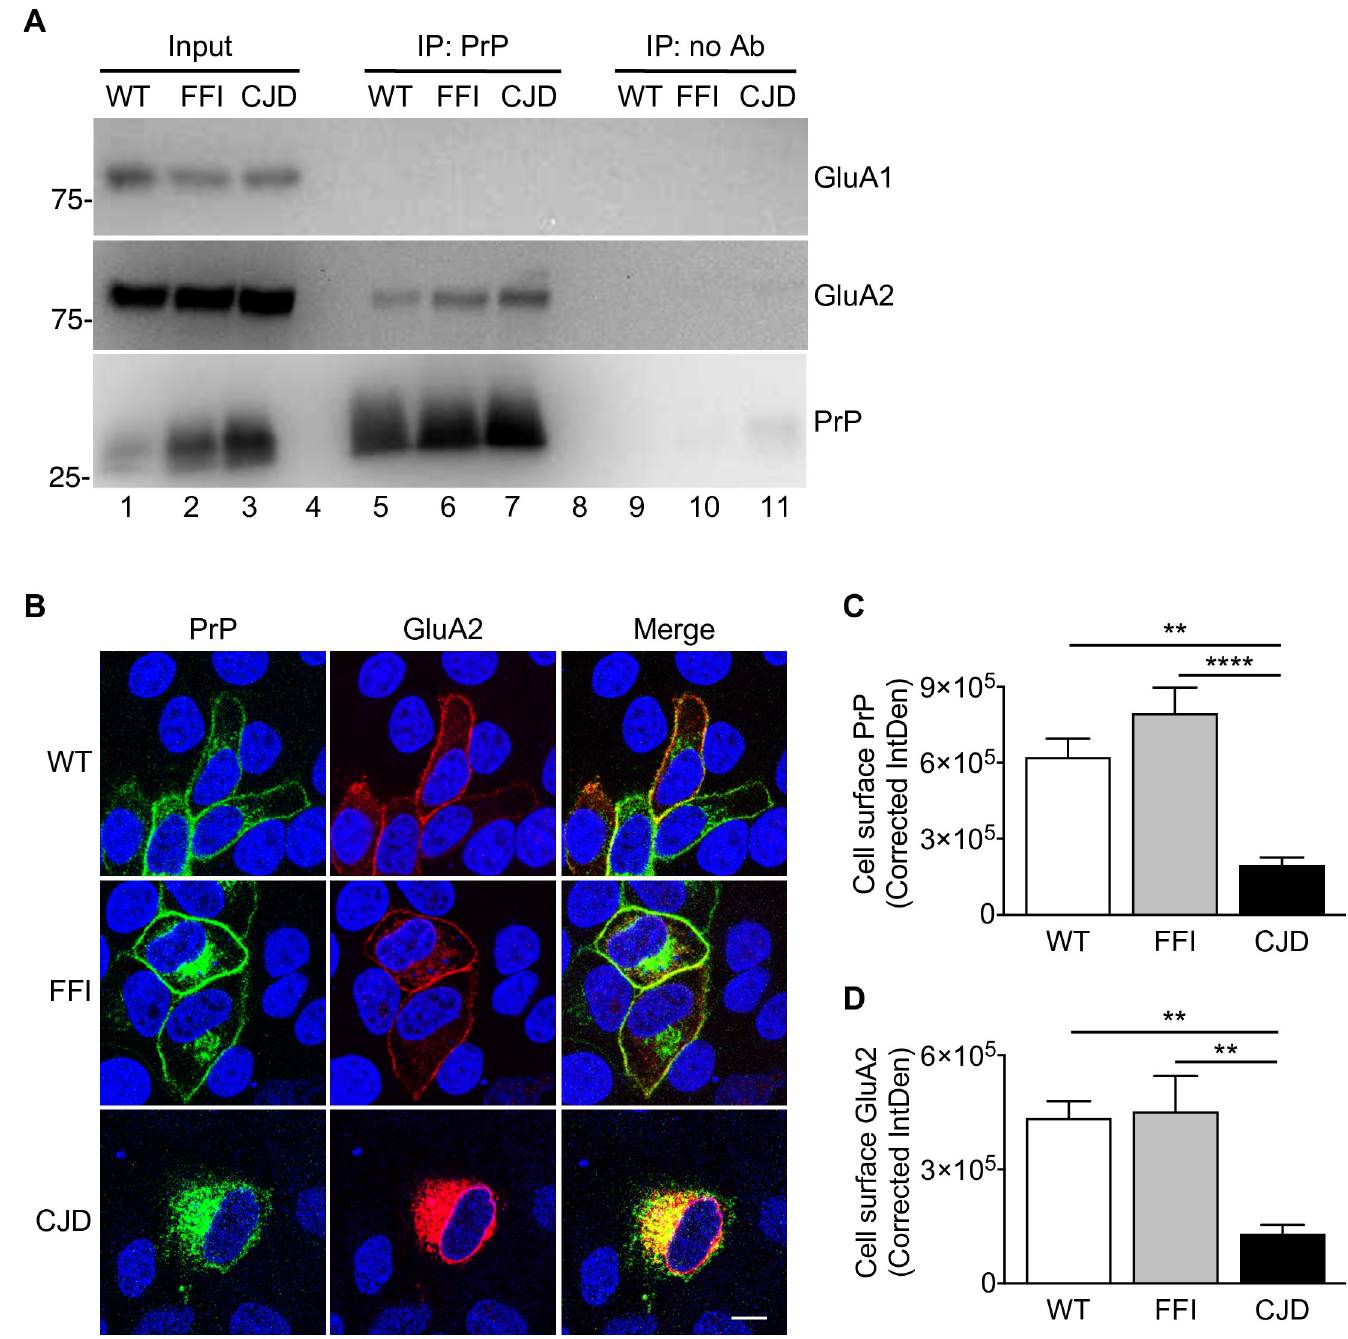
Fig 2. Mutant PrP interacts with the GluA2 AMPAR subunit impairing its membrane delivery. (A) Hippocampal protein extracts (500 μ g) from WT, FFI and CJD mice were incubated with uncoated magnetic beads (IP: no Ab) or magnetic beads coated with anti-PrP monoclonal antibody 94B4 (IP: PrP). The immunoprecipitated proteins were analyzed by western blot with anti-GluA1 or anti-GluA2 antibody or anti-PrP polyclonal antibody P45-66. The input is 20 μ g of total proteins. Lanes 4 and 8 were left empty on purpose. This experiment is representative of three similar ones. (B) HeLa cells were co-transfected with plasmids encoding WT, FFI or CJD PrP-EGFP fusion protein, and the AMPAR subunit GluA2. After 48h, cells were fixed, permeabilized, stained with anti-GluA2 (red) antibody, and reacted with Hoechst 33258 (blue) to stain the nuclei. Scale bar 10 μ m. (C, D) The fluorescent density of PrP and GluA2 on the cell surface was measured and background corrected (Corrected IntDen). Each bar indicates the mean ± SEM of 12–17 tranfected cells from three independent experiments. �� p < 0.01, ���� p < 0.0001 by one-way ANOVA, Tukey’s post hoc test.